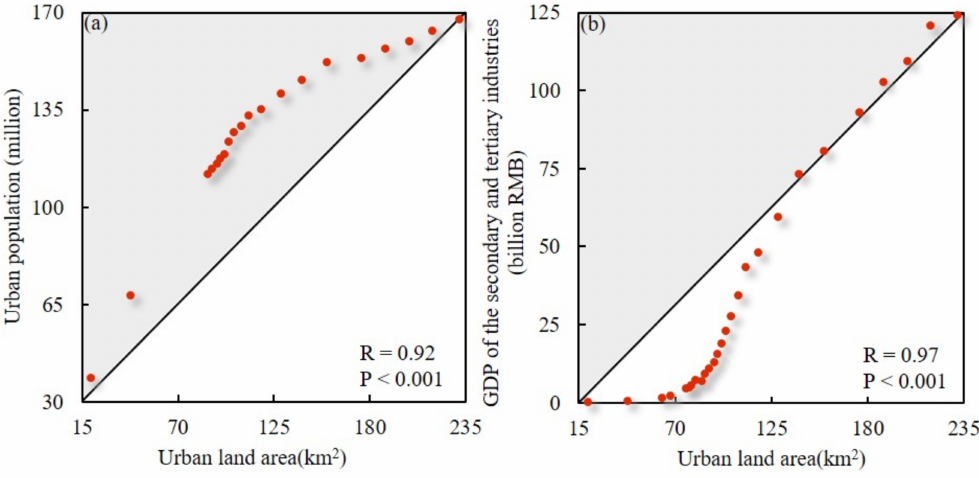
Figure 8. Accuracy assessment based on socio-economic data of Xining City. ( a ) the relationship between urban population and urban land area; and ( b ) the relationship between GDP and urban land